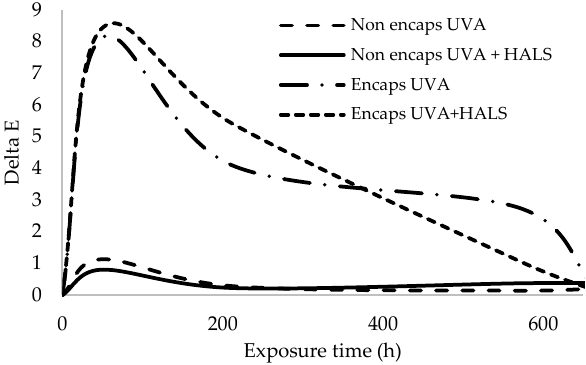
Figure 10. Evolution of Δ E for the different formulations on glass panels with Weather-Ometer exposure.